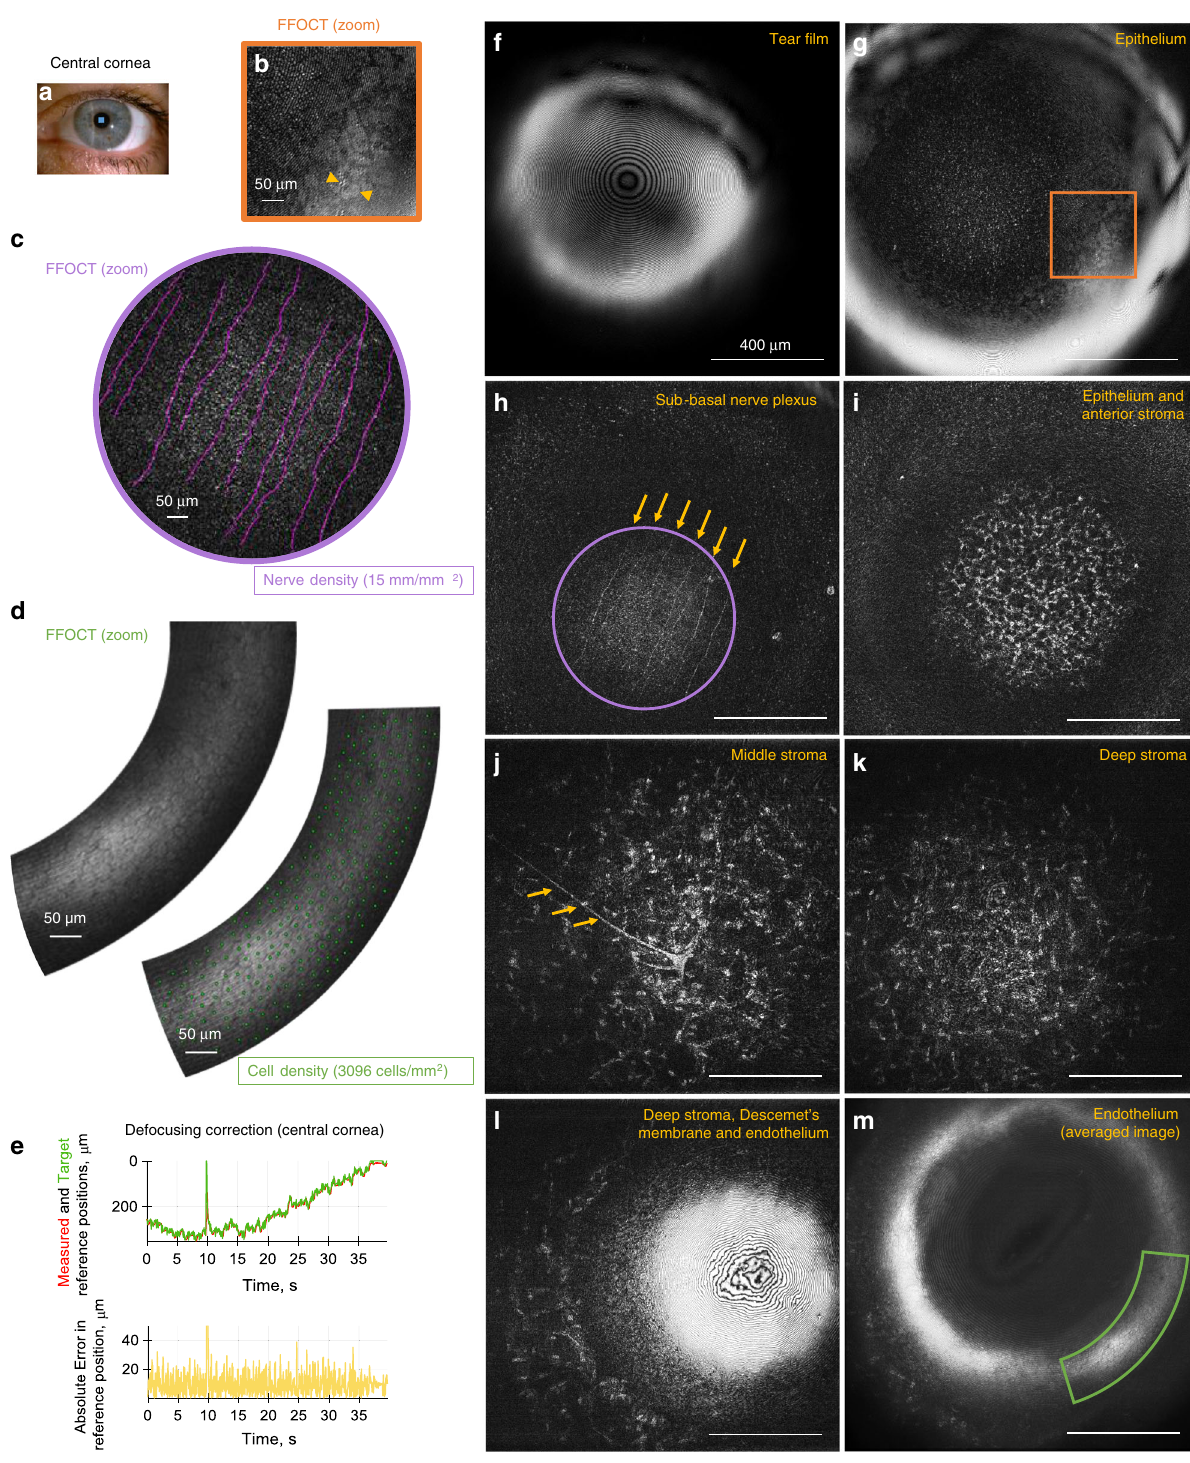
Fig. 5 Common-path FF/SD OCT imaging of central human cornea in vivo. a Slit-lamp macro photo obtained from one of the subjects. Blue square depicts the FFOCT fi eld of view. b Zoomed and bandpass fi ltered (see Methods section) FFOCT image of super fi cial epithelial cells with dark nuclei. c Zoomed FFOCT image of sub-basal nerves. NeuronJ 24 was used for nerve tracing and quanti fi cation. d Zoomed FFOCT image of endothelial cell mosaic. ImageJ 47 point tool was used for cell counting. e Performance of real-time defocus correction, when imaging in vivo human corneal center. Measured reference mirror position (red), required reference location for ideal defocus correction (green) and error between the two (yellow). The peak at 10 s corresponds to a blink. Positioning error was 9.4 ± 6.2 µ m (mean ± s.d.), estimated from 1488 positions acquired over 38.6 s. f – m Single frame FFOCT images through the entire thickness of the central cornea extracted from the real-time movies (Supplementary Movies 6, 7). Surface epithelial cells, sub- basal, and stromal nerves (yellow arrows), keratocyte cells and their nuclei, and endothelial cells were visible. The source data underlying plots in e are provided as a Source Data fi le. All unlabeled scale bars 400 µ m. Experiments were reproduced several times in each of the three healthy